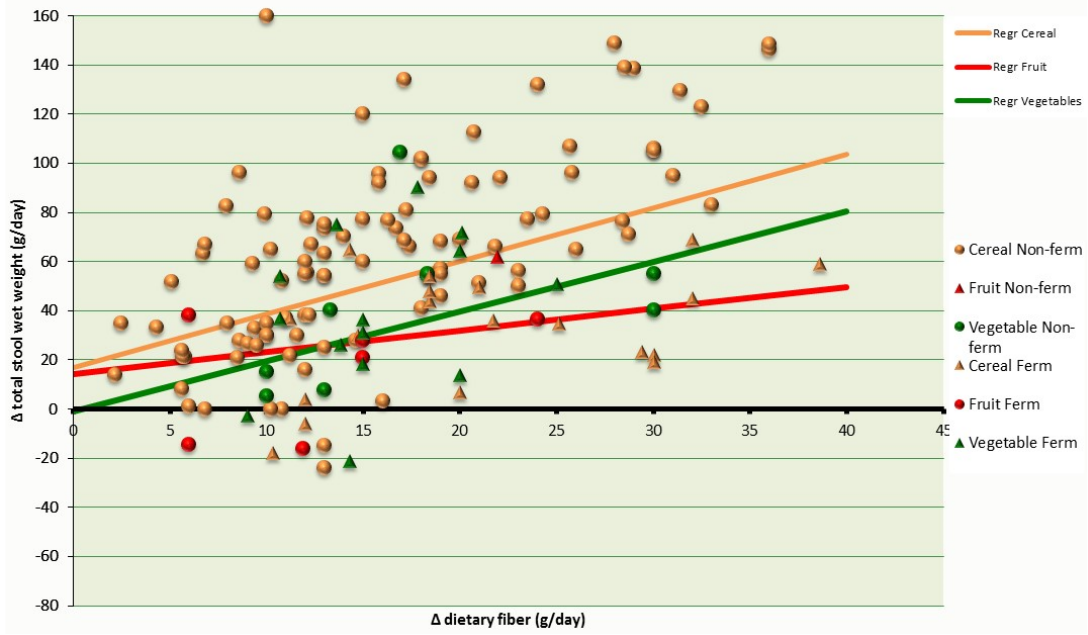
Figure 2. Changes in the weight of total fecal output (g/day) related to dietary fiber intervention (g/day) in healthy individuals. Dietary fiber is grouped according to food origin. Cereal Non-ferm: less fermentable dietary fibers from cereals; Fruit Non-ferm: less fermentable dietary fibers from fruits; Vegetable Non-ferm: less fermentable dietary fibers from vegetables; Cereal Ferm: more fermentable dietary fibers from cereals; Fruit Ferm: more fermentable dietary fibers from fruits; Vegetable Ferm: more fermentable dietary fibers.